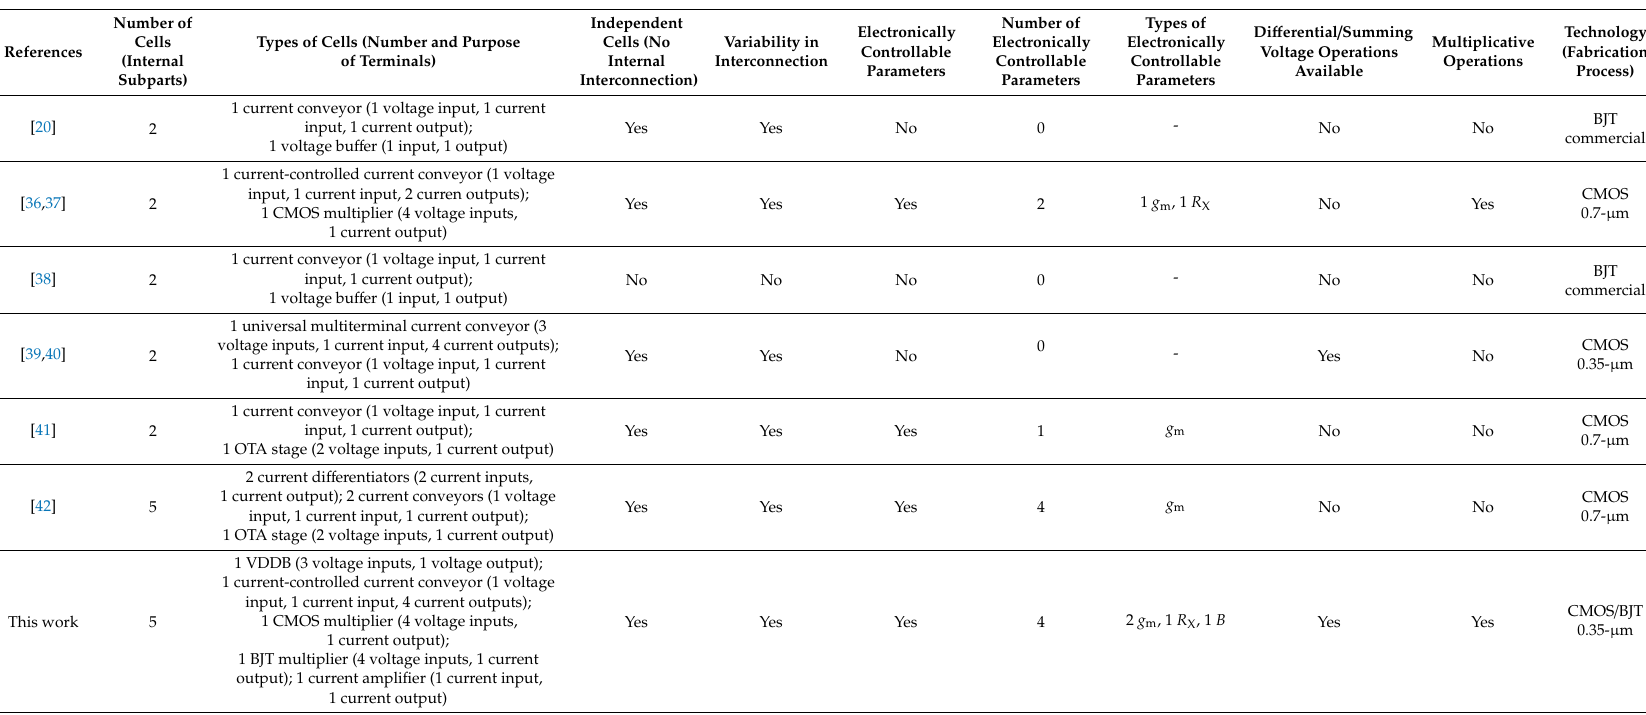
Table 1. Comparison of typical examples of commercially available devices to relevant customized modular IC